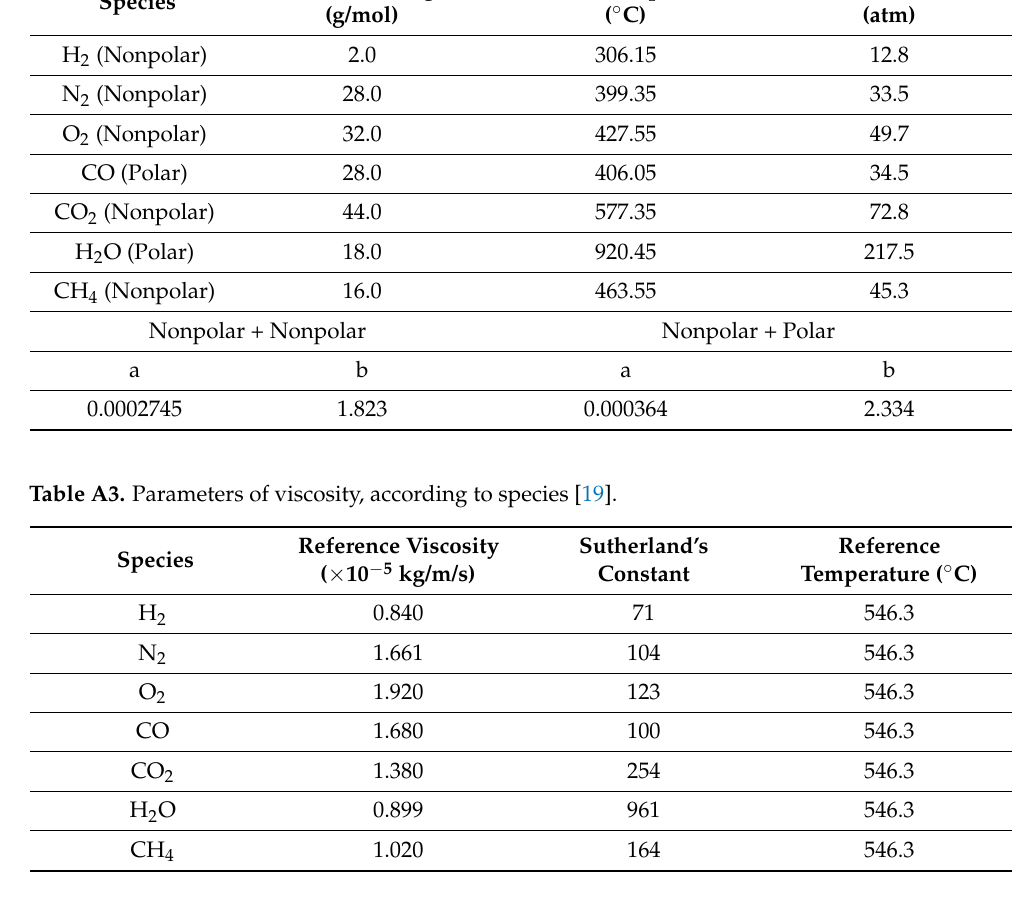
Table A4. Parameters of thermal conductivity, according to species